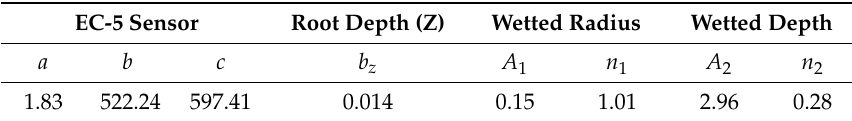
Table 2. The coefficients of the EC-5 sensor, root depth model, and wetting pattern model.